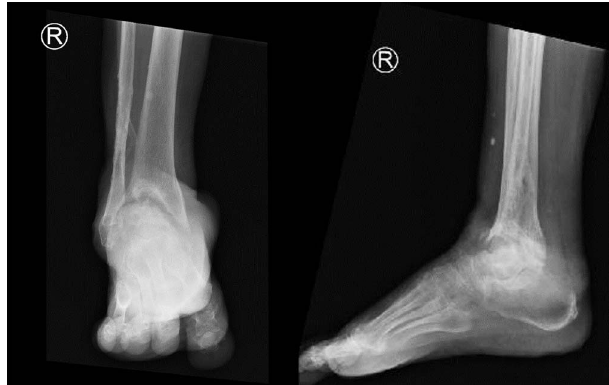
Figure 1. Ankle radiograph showing ankle osteoarthritis with irregular surface that will hamper the bony